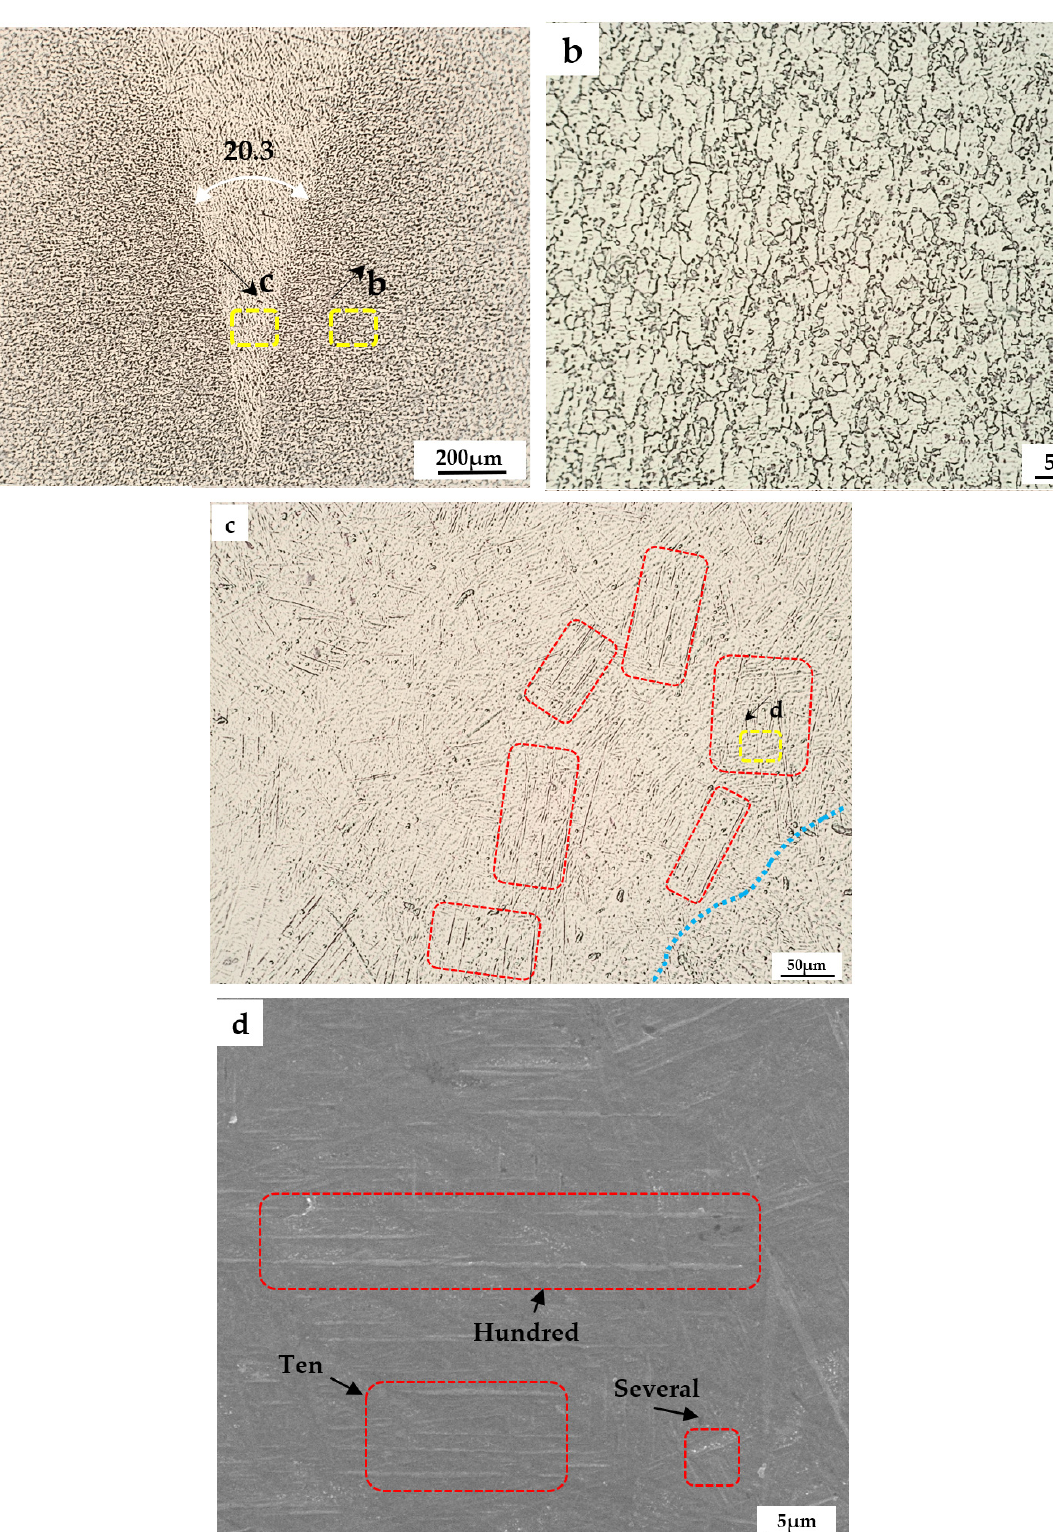
Figure 4. Ti ‐ 6Al ‐ 4V remelted zone grain morphologies under different magnifications: ( a ) Low magnification metallographic photo; ( b ) Enlargement in the corresponding yellow box of ( a ); ( c ) En- largement in the corresponding yellow box of ( a ); ( d ) Enlargement in the corresponding yellow box of ( c ). Red box: typical